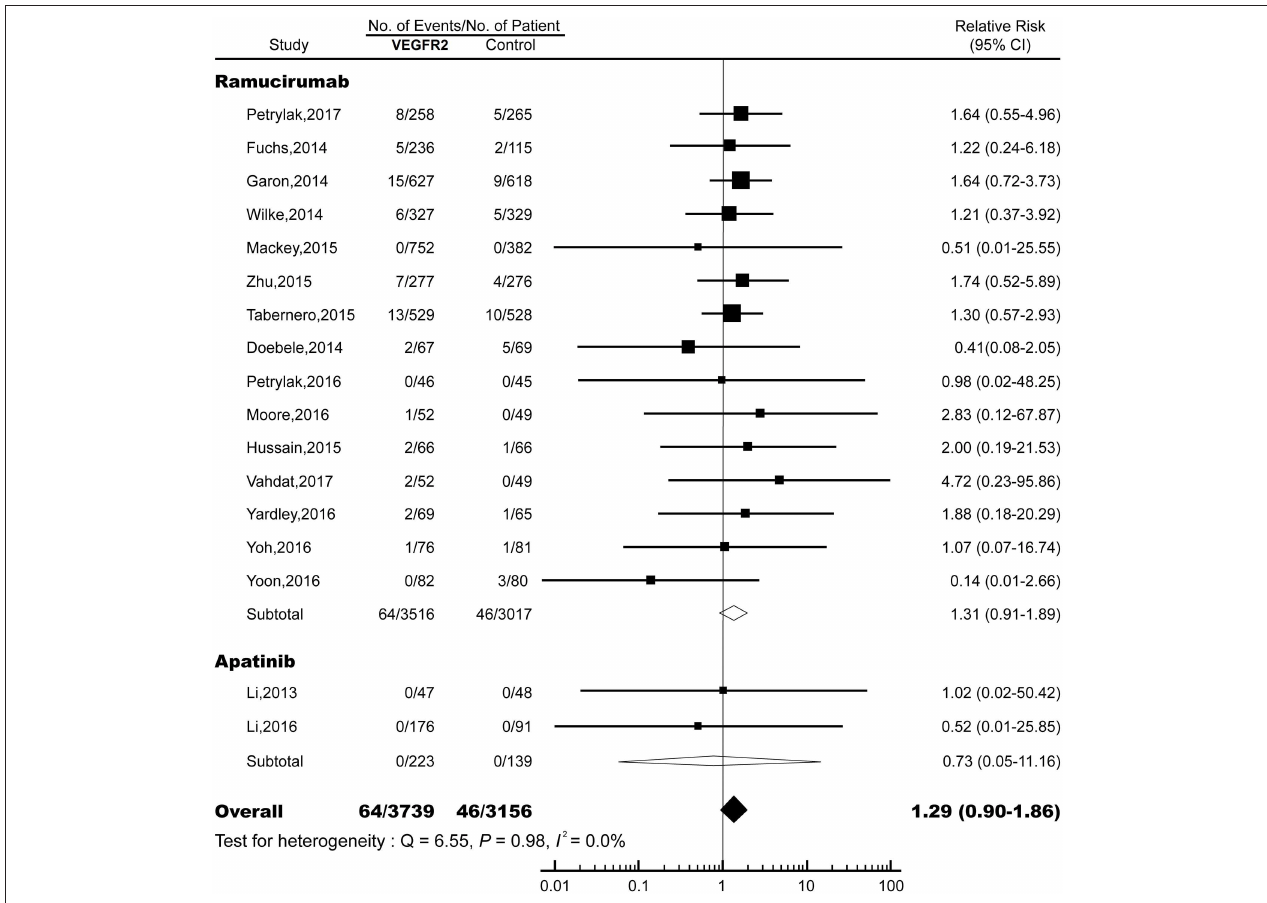
FIGURE 2 | Relative risk (RR) of fatal adverse events (FAEs) associated with VEGFR2-targeted agents vs. control. Overall risk of FAEs was calculated by fixed-effects models.